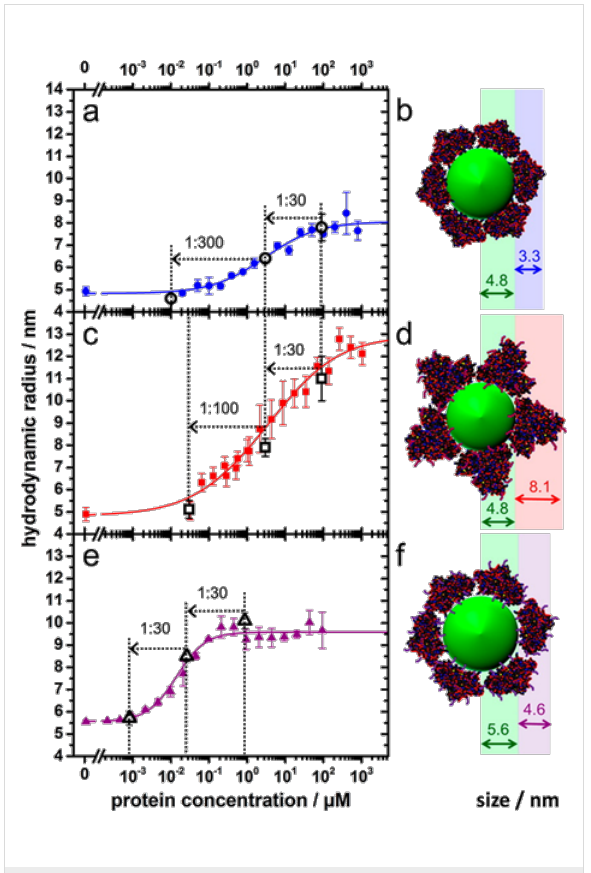
Figure 4: Binding curves as determined by fluorescence correlation spectroscopy and schematic representations for adsorption of (a and b) HSA, (c and d) HSAsuc and (e and f) HSAam onto dihydrolipoic acid-coated quantum dots. Filled symbols: Hydrodynamic radii of DHLA-QDs plotted as a function of the concentration of (a) HSA, (c) HSAsuc and (e) HSAam free in solution. Solid lines represent fits